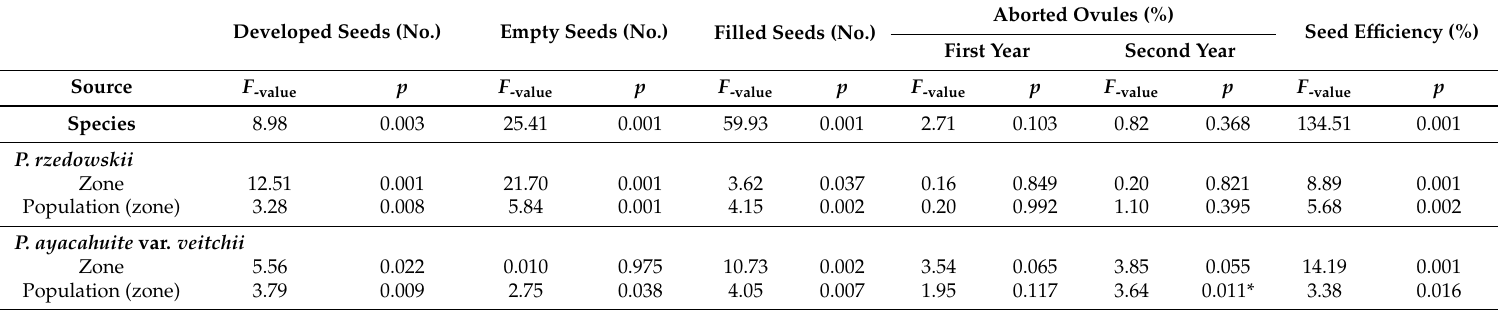
Table 3. Summary of the General Lineal Mixed Model to test differences among cone and seed reproductive indicators between P. rzedowskii and P. ayacahuite var. veitchii species (overall model) and differences among zones and among populations within zones (one model per species). Developed Seeds